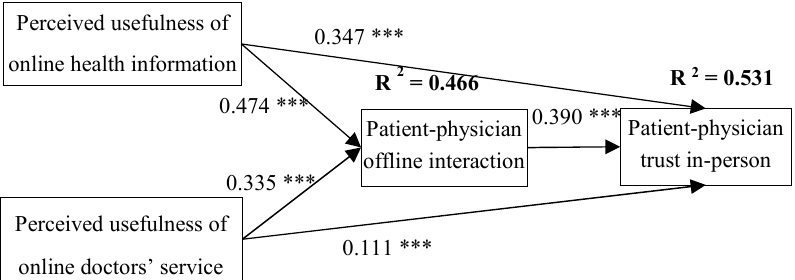
Figure 2. Analysis results of structural model. (*** Statistically significant at the 1% level; ** Statistically significant at the 5% level; * Statistically significant at the 10% level, two-sided test).